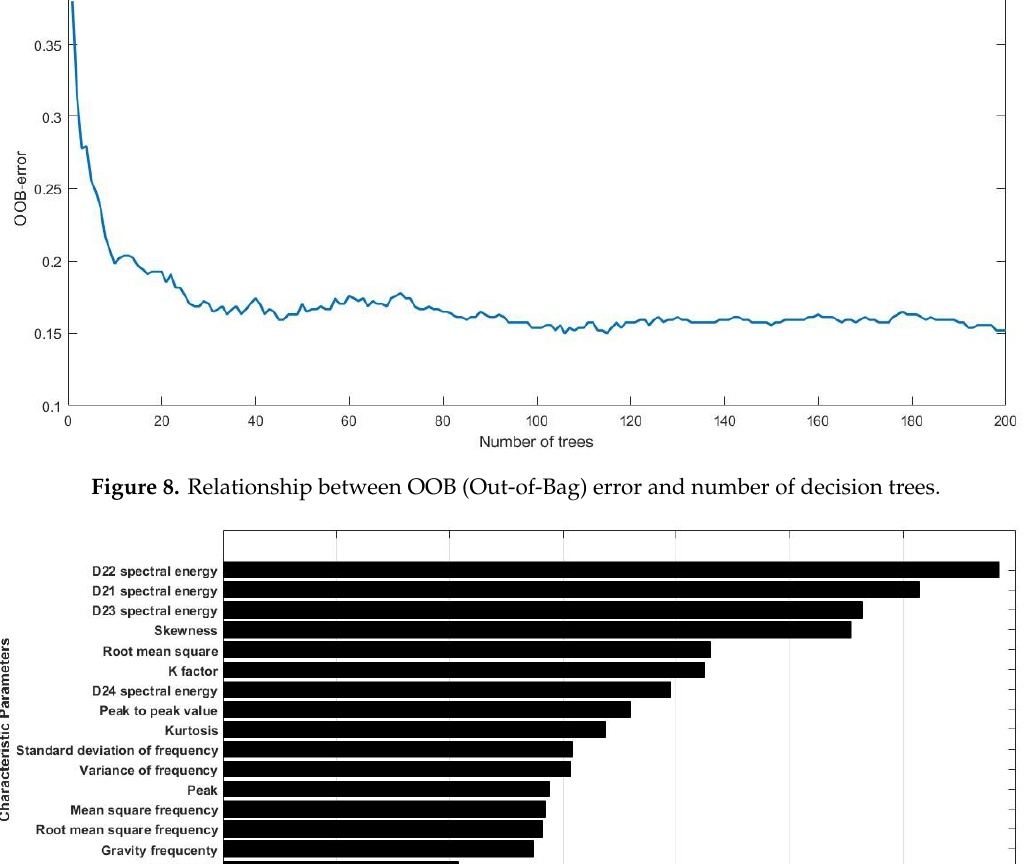
Figure 9. Importance score’s ranking of variables.